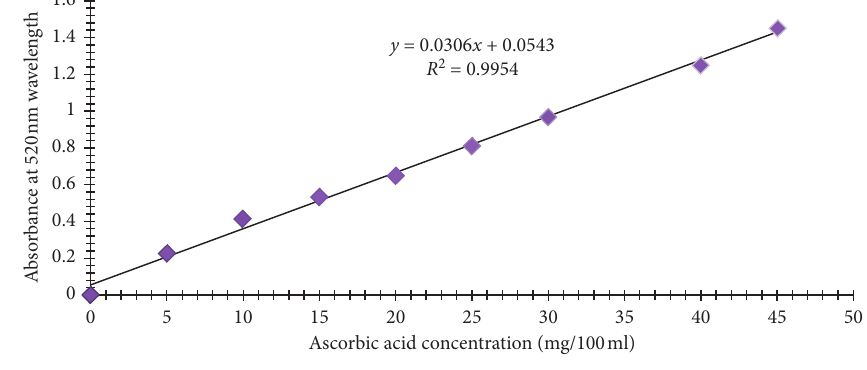
Figure 1: Calibration graph plot of pure ascorbic acid.